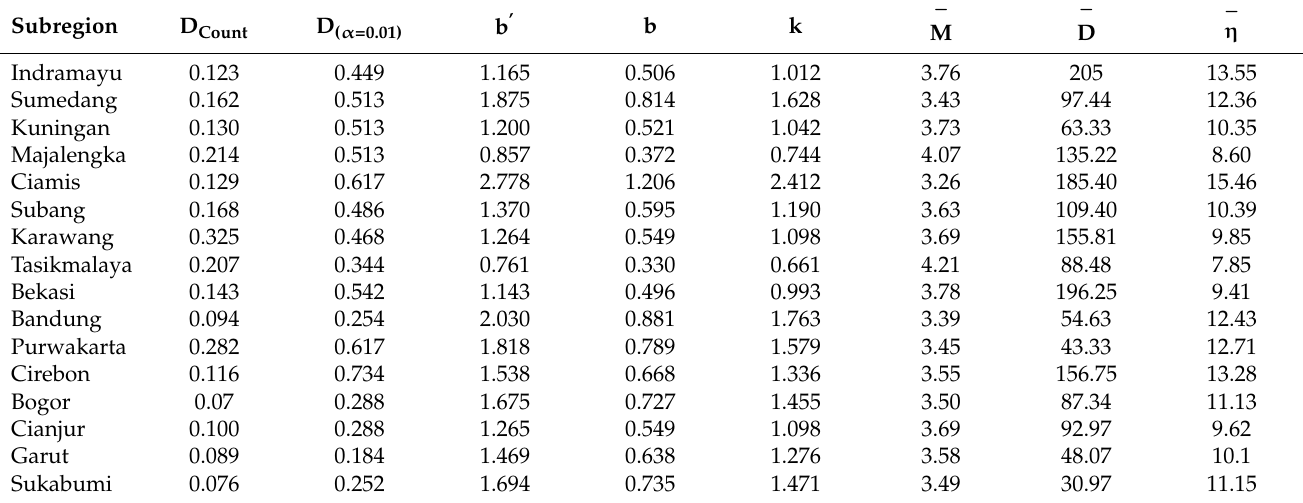
Table 4. The result of KS test, and the value of b (cid:48) ,b,k,M, D, η .